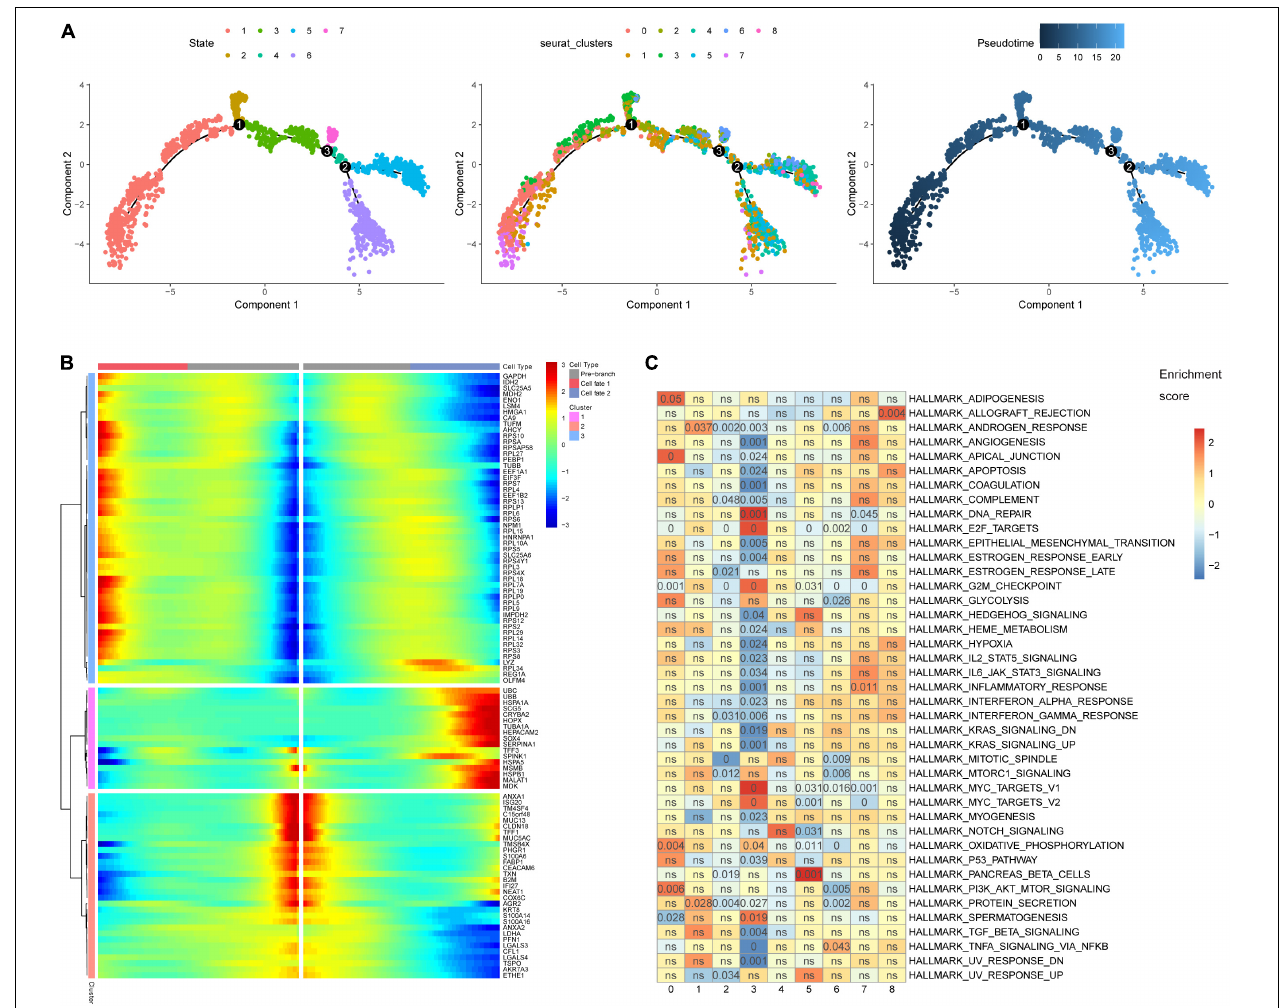
FIGURE 4 | Pseudotime analysis and gene set enrichment analysis (GSEA). (A) The malignant cell differentiation trajectory plot, (B) The heat map for the expression patterns of the top 100 significant genes (ranked by q value) in branched expression analysis modeling (BEAM). (C) The eight malignant cell clusters were enriched in various hallmark gene sets. The number in the grids refers to the p value adjusted by the false discovery rate (FDR).